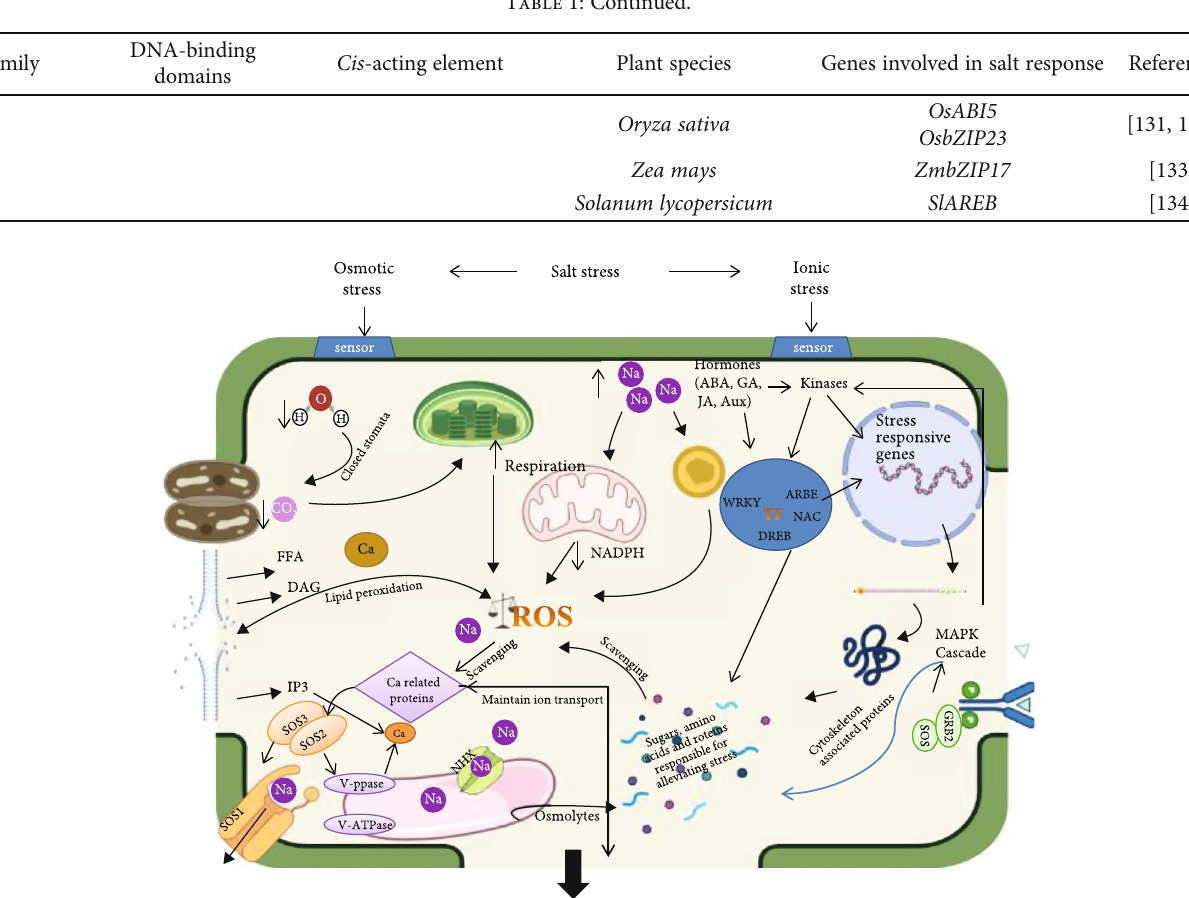
Figure 3: Mechanism of salinity tolerance in plants. The excess in fl ux of sodium causes ion toxicity and water de fi cit, which results in the closure of stomata and decreased availability of CO for photosynthetic ETC. This water de fi cit eventually causes ion imbalance and 2 overproduction of ROS in chloroplast, mitochondria, peroxisomes, and apoplastic space. In response, the plants increase enzymatic/non enzymatic antioxidants and osmolytes. Transporters like NHX sequester Na + inside the vacuole and SOS1 extrudes Na + outside the cell. In this response, there is an increased expression of salt-responsive genes, transcription factors (TFs), and kinases inside the cell, which help the plants to alleviate the stresses encountered by